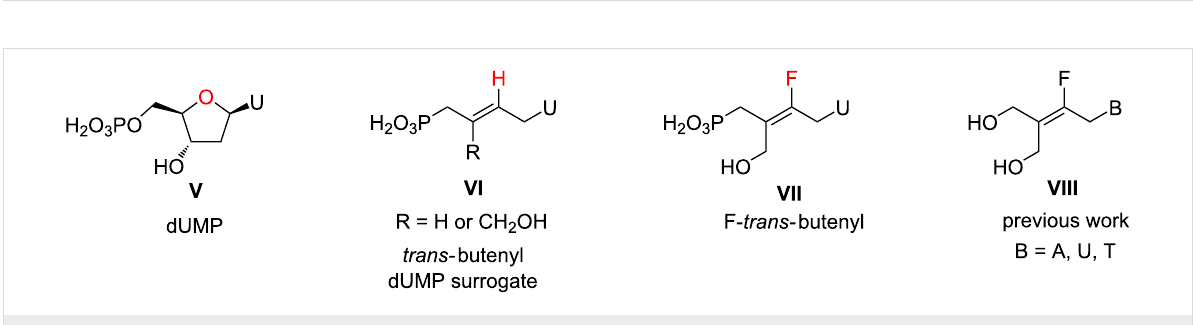
Figure 1: Representative fluorinated nucleos(t)ides and acyclonucleotides.